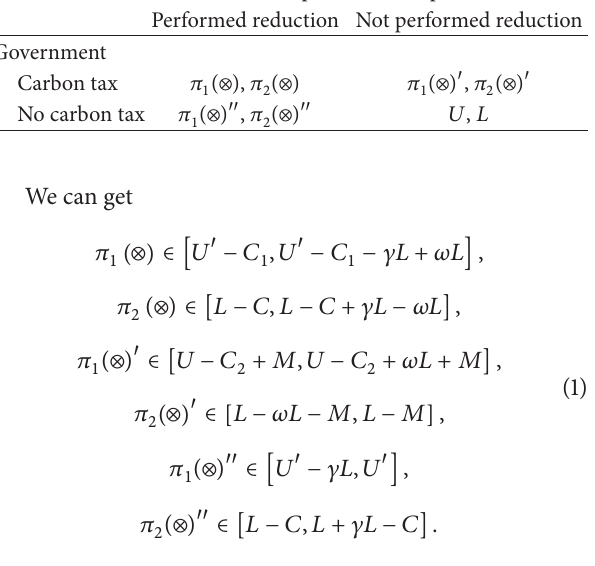
Table1:Agreyprofitandlossmatrixofgovernmentandtransporta- tion